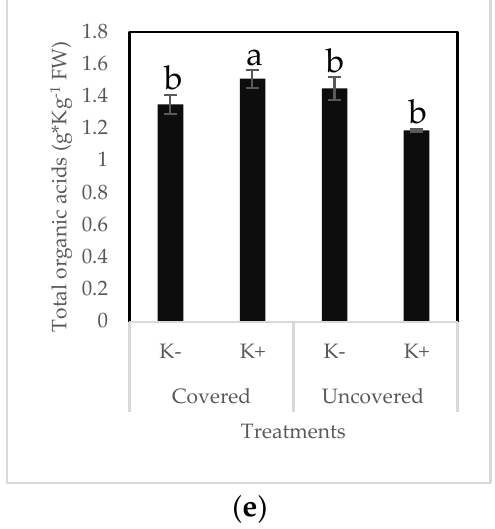
K- K+ K- K+ Covered Uncovered